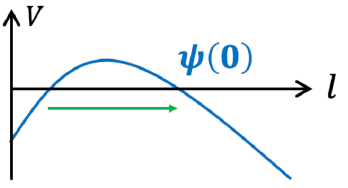
Figure 4 . Creation of a small mother universe from